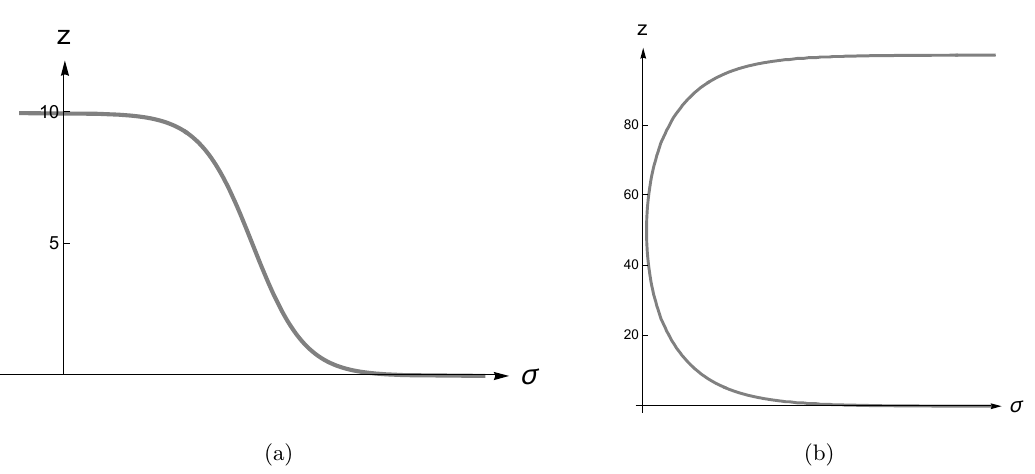
Figure 2 . Plots of the positions of a D8-brane and of a D6-brane domain